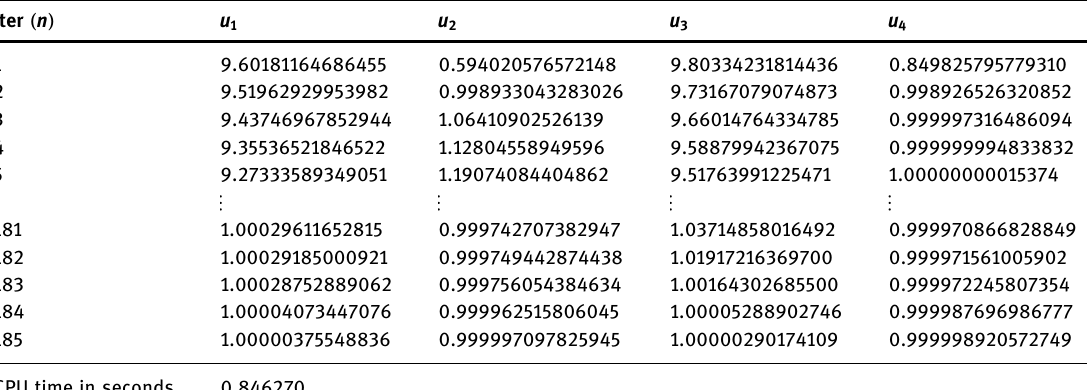
Table 9: Example 4.2: Numerical study of Algorithm 2 in [ 30 ]